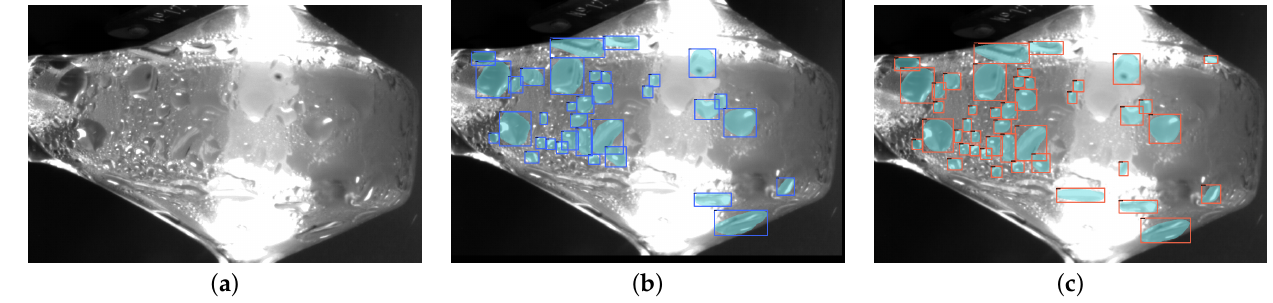
Figure 11. The results of the beading detection pipeline on a Basler image. The input image ( a ), with ground truth labels ( b ), shows inference results in ( c ).